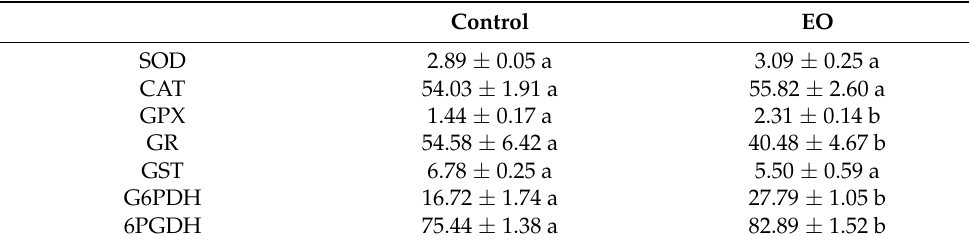
Data are mean ± standard error of the mean and are expressed in milliunits/milligram of protein (SOD, GPX, GR, GST, G6PDH, 6PGDH) or units/milligram of protein (CAT). In each row, comparing control versus EO, values followed by different letters, a or b, are significantly ( p < 0.05)